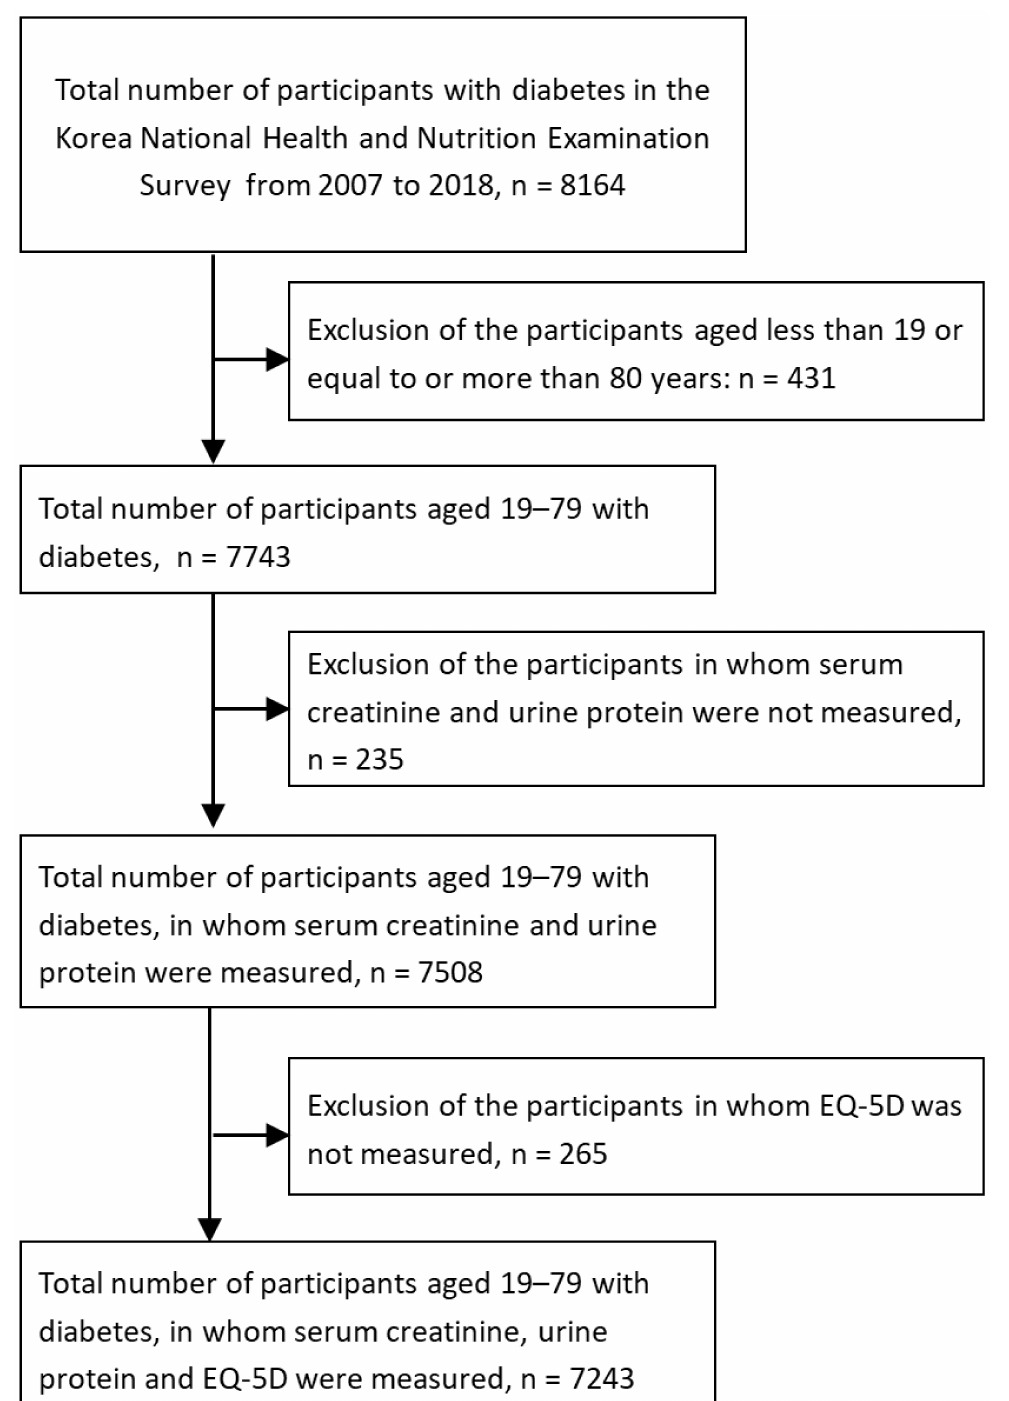
Figure 1. Flowchart of study